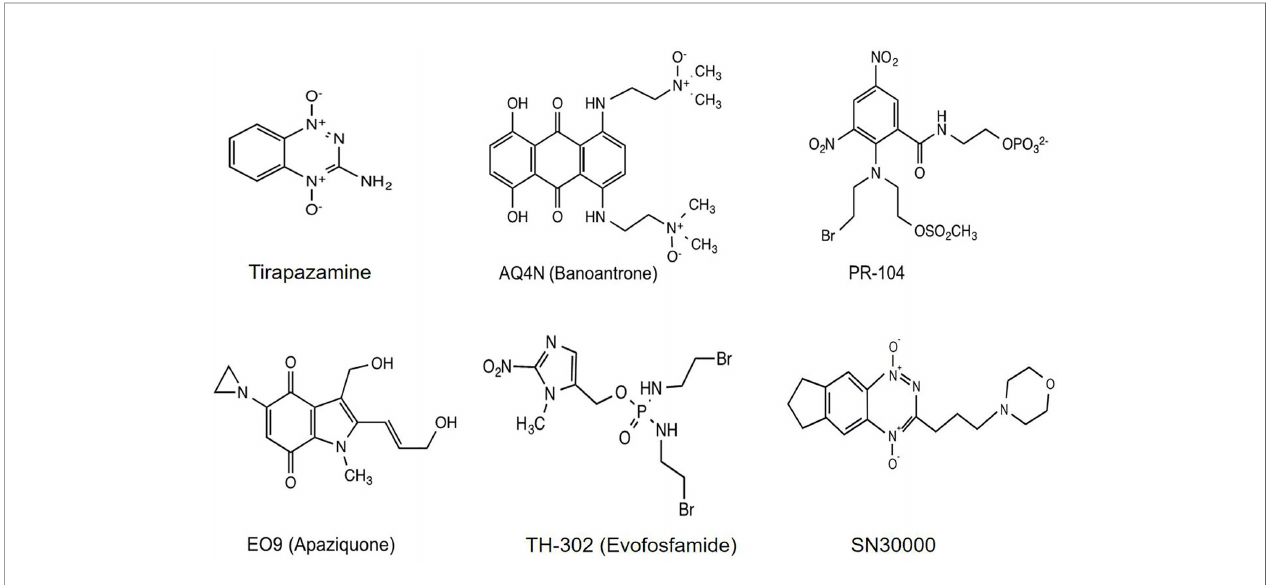
FIGURE 1 | Chemical structures of representative